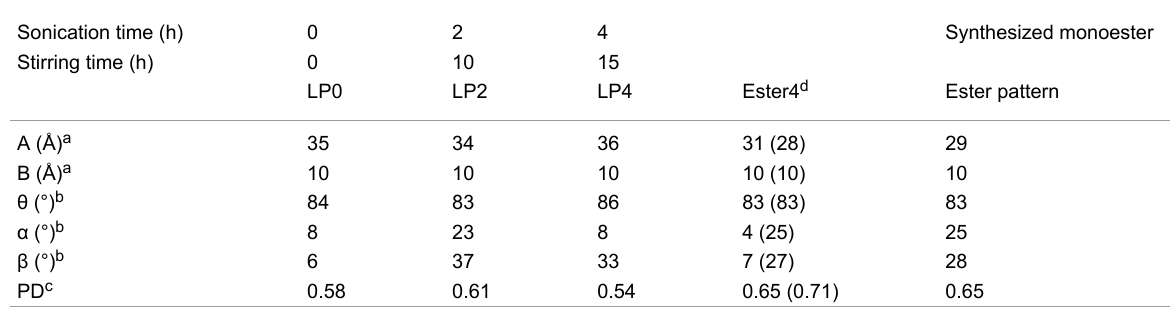
Sonication time